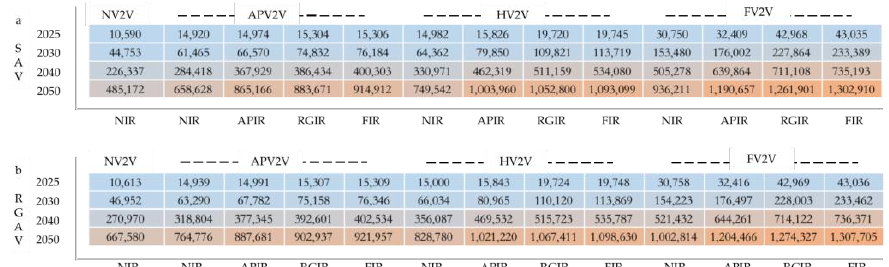
Figure 5. ( a , b ), Cumulative reductions in road fatalities for each AV synergetic scenarios: SAV ( a ), RGAV ( b ). Panel rows show variation by V2V equipment (scenarios NV2V, APV2V, HV2V, and FV2V, Table 1); columns show variation by IR scenarios (abbreviations as in Table 1).